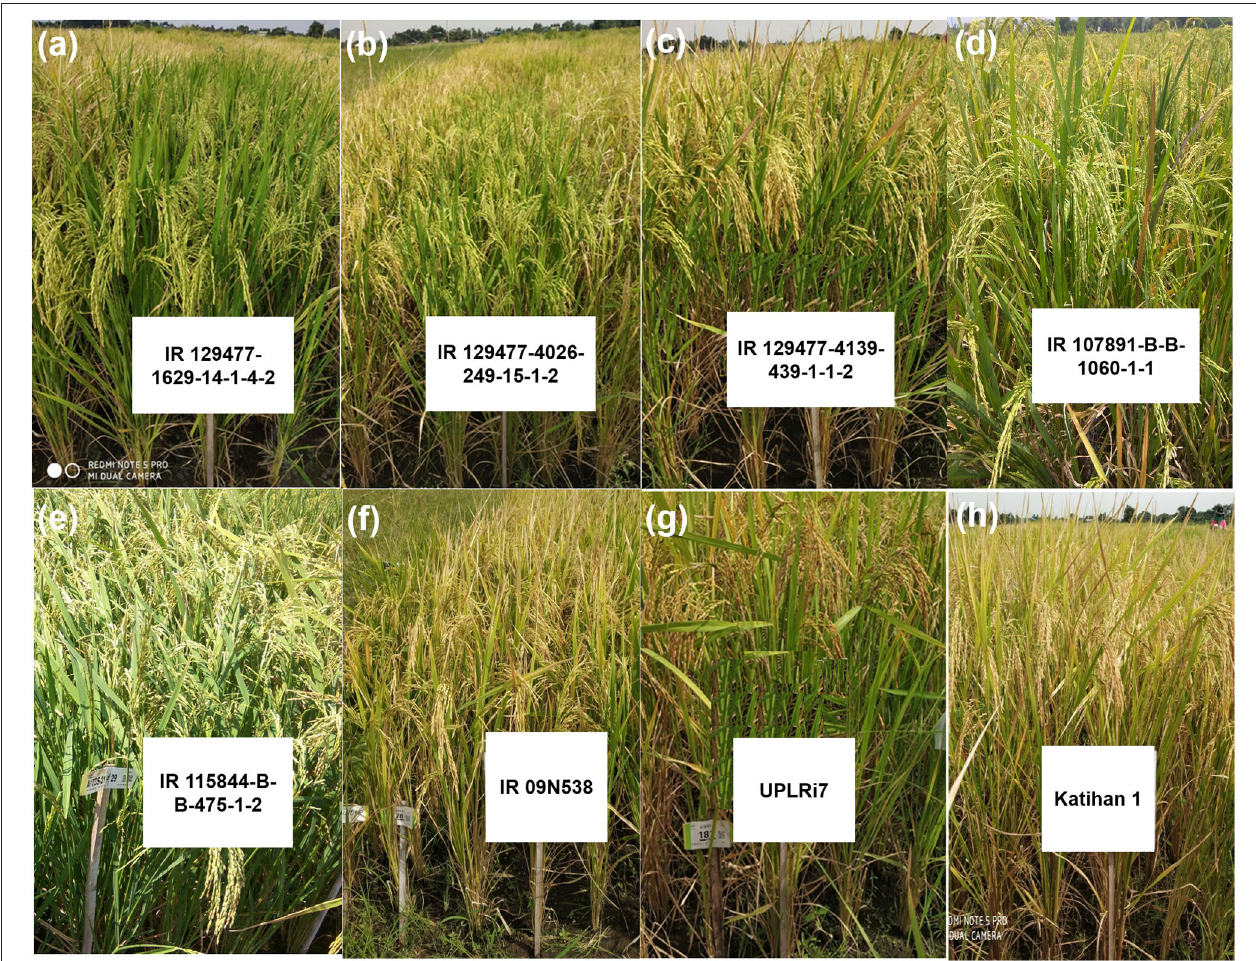
FIGURE 3 | Selected promising breeding lines from (a–c) genomics-assisted breeding program (d,e) , conventional breeding program, and (f) recipient variety used in genomics-assisted breeding program (g,h) for upland adapted check